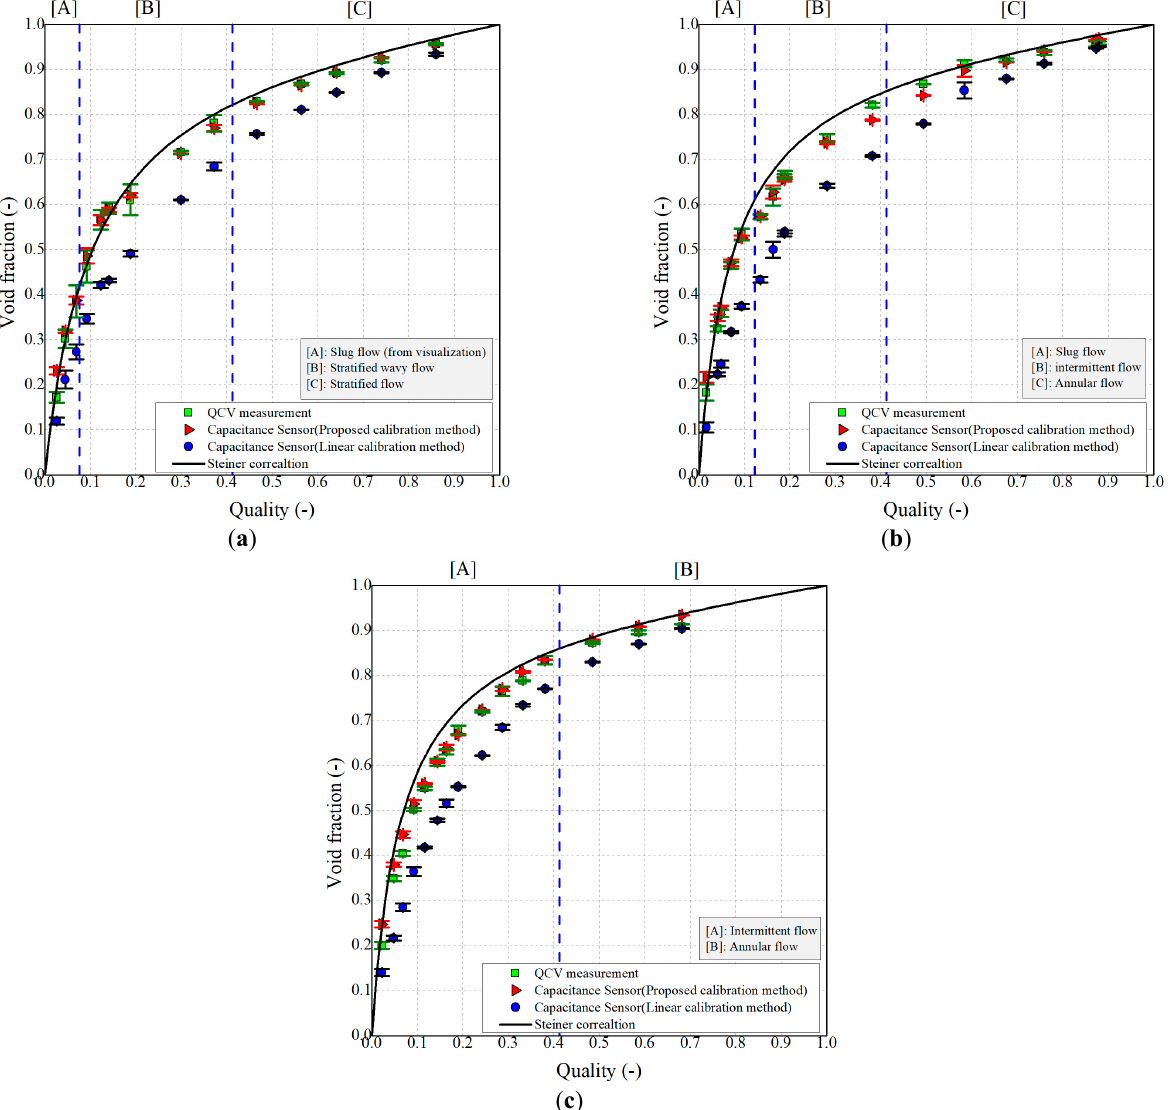
Figure 9. Comparison between the QCV-technique-derived void fraction results and those obtained via the capacitance method with the proposed and linear calibration; ( a ) R32, T = 25 °C, G = 100 kg m − 2 s − 1 ; ( b ) R32, T = 25 °C, G = 250 kg m − 2 s − 1 ; ( c ) R32, T = 25 °C, G = 400 kg m − 2 s − 1 .